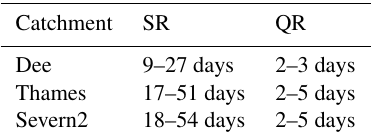
Table 3. SR (slow response) and QR (quick response) timescales for the cross-spectral analysis conducted at three catchments in Sect.